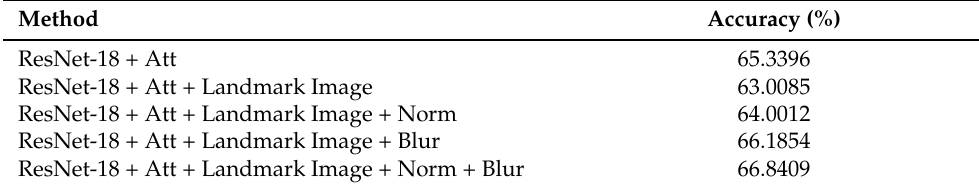
Table 7. Comparison of facial landmark feature extraction methods.